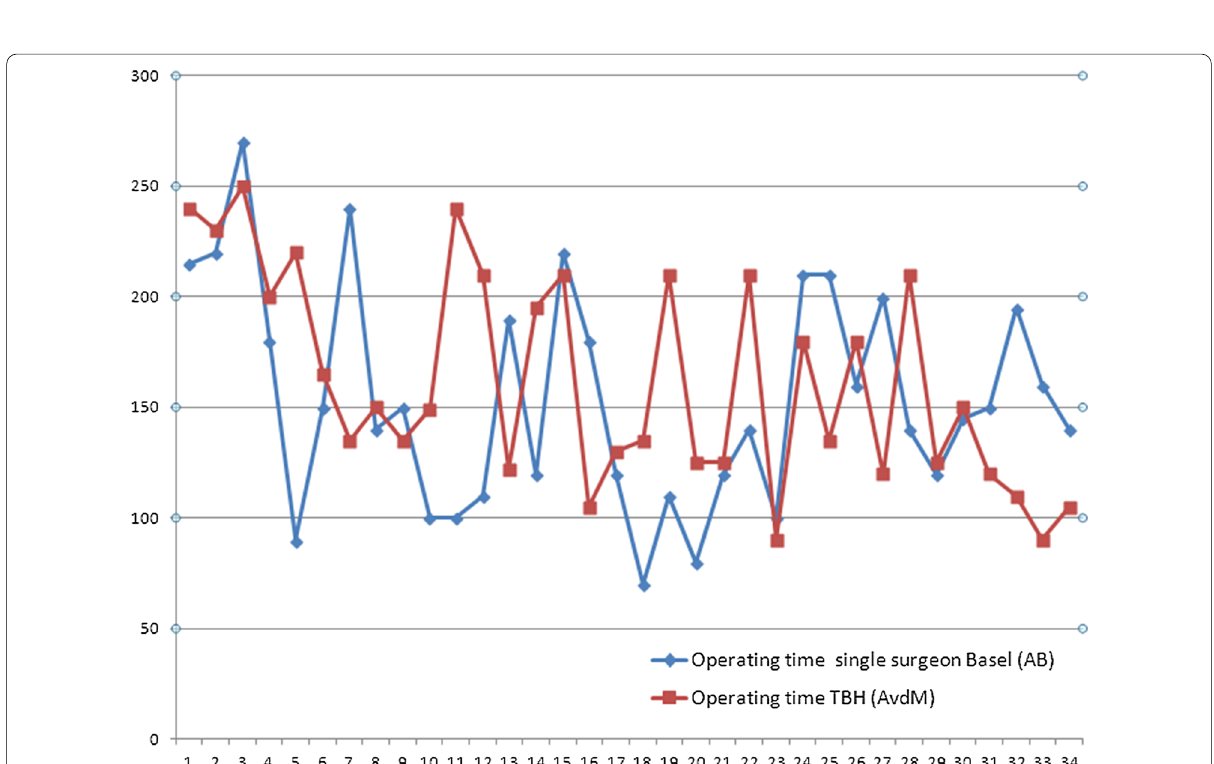
Fig. 2 Operative times in minutes of a single Basel surgeon and the Tygerberg